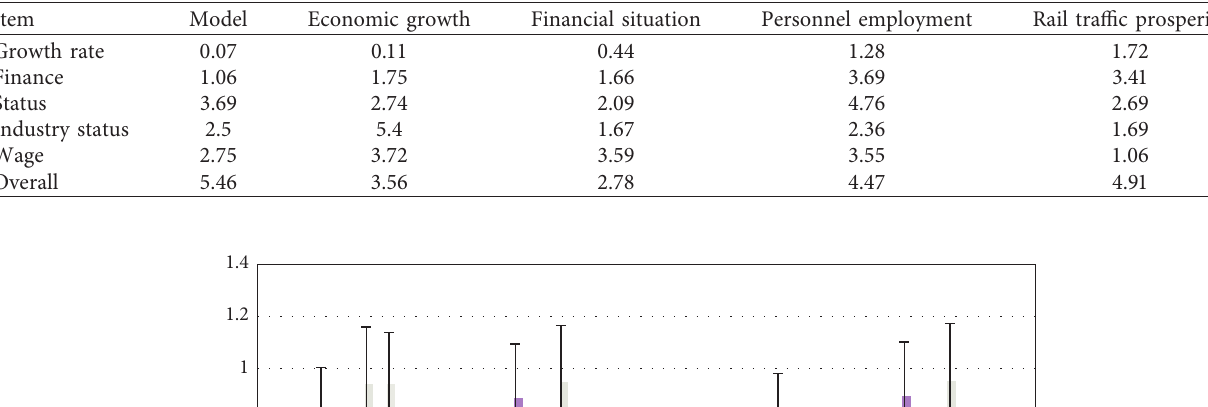
Figure 1: Coordinated relationship between economic evaluation indicators and financial status. Table 2: The construction and analysis of the high-speed railway economic hub.